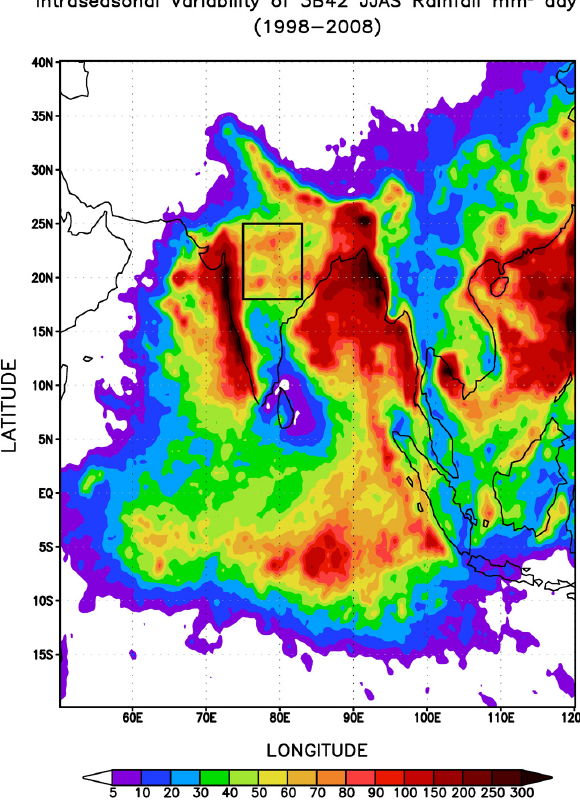
Fig. 2. Intra-seasonal variability of JJAS rainfall (mm 2 day − 2 ) based on 3B42